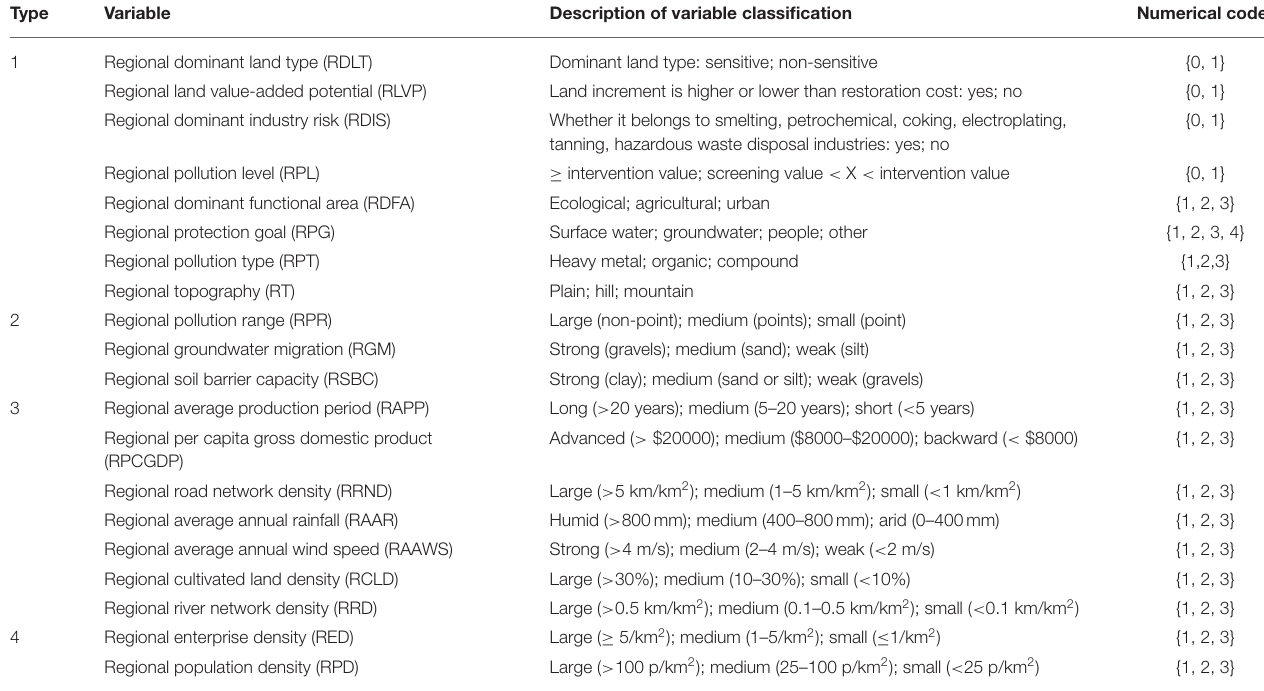
TABLE 1 | Description of vectorization rules of characteristic